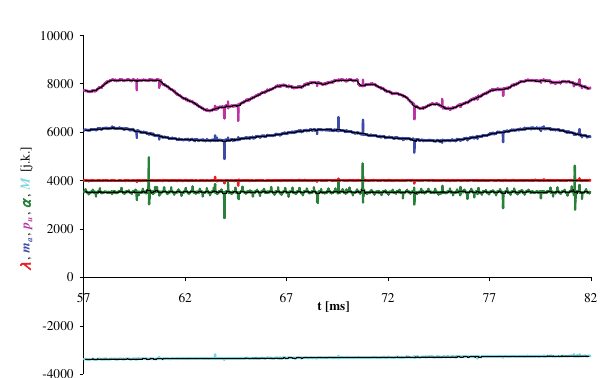
Fig. 9. Analogue signals before and after averaging with the use of method of average from 20 samples (black lines represent averaged processes)